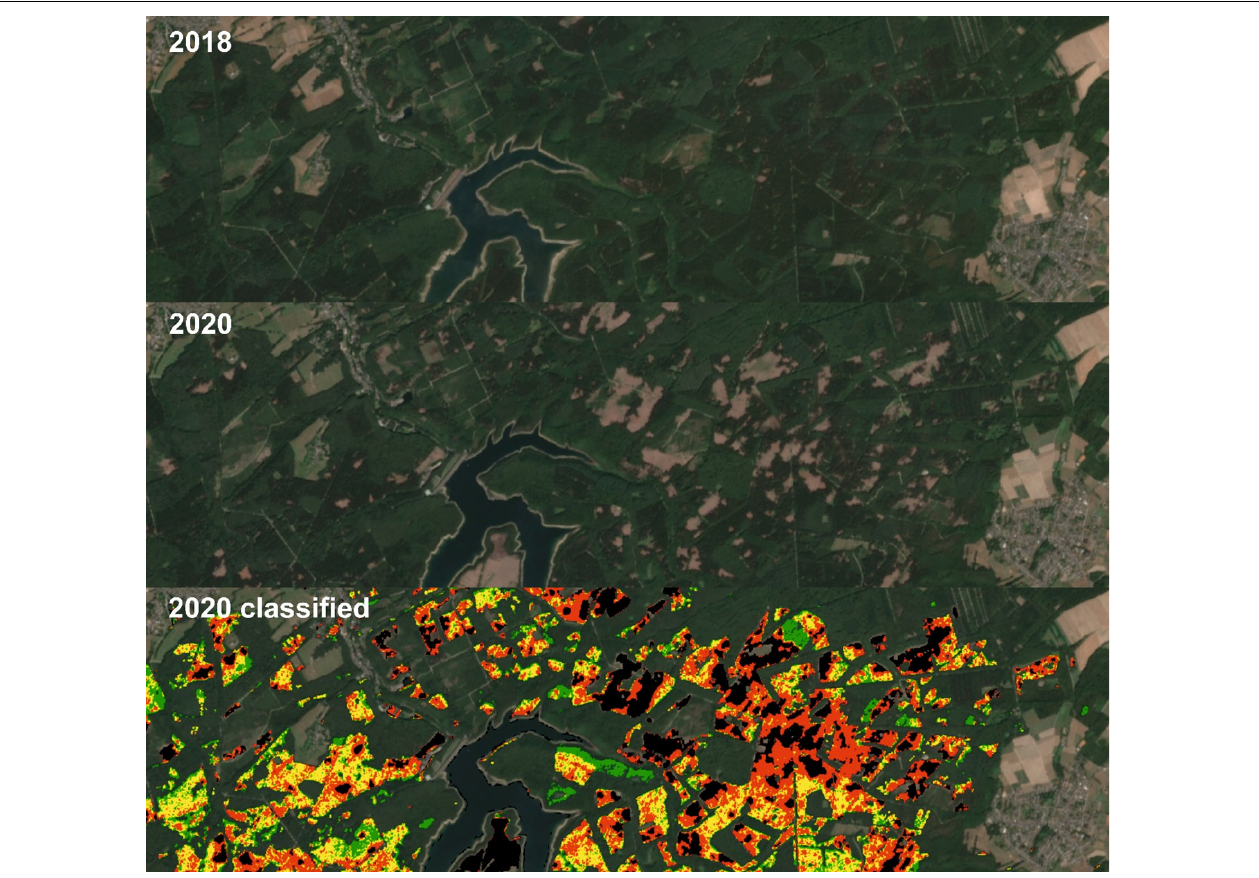
FIGURE 8 | Sentinel-2 data (RGB = B4, B3, and B2) of the Wehe dam area in the Venn anticline for 2018 (top), 2020 (middle, CDF matched), and estimated spruce health classes in 2020 (bottom, removed = black, damaged = red, warning level = yellow, and healthy =